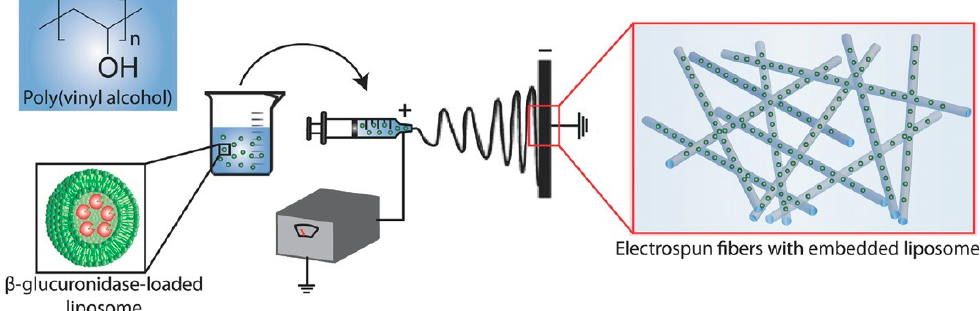
Figure 2. Scheme of assembly of electrospun polymeric fibers with embedded liposomes containing enzymes. Reproduced from [77] with permission from Creative Commons Attribution License.